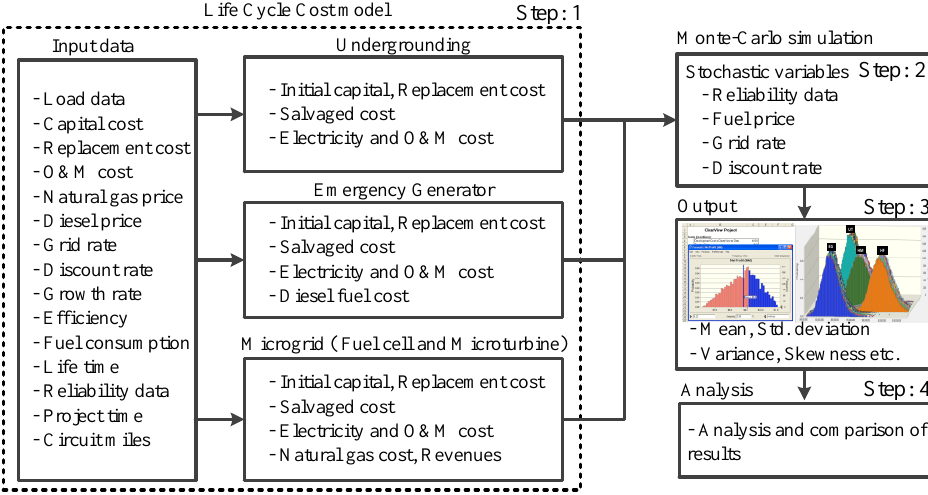
Figure 2. Approach for estimating life cycle cost (LCC) of hardening options.